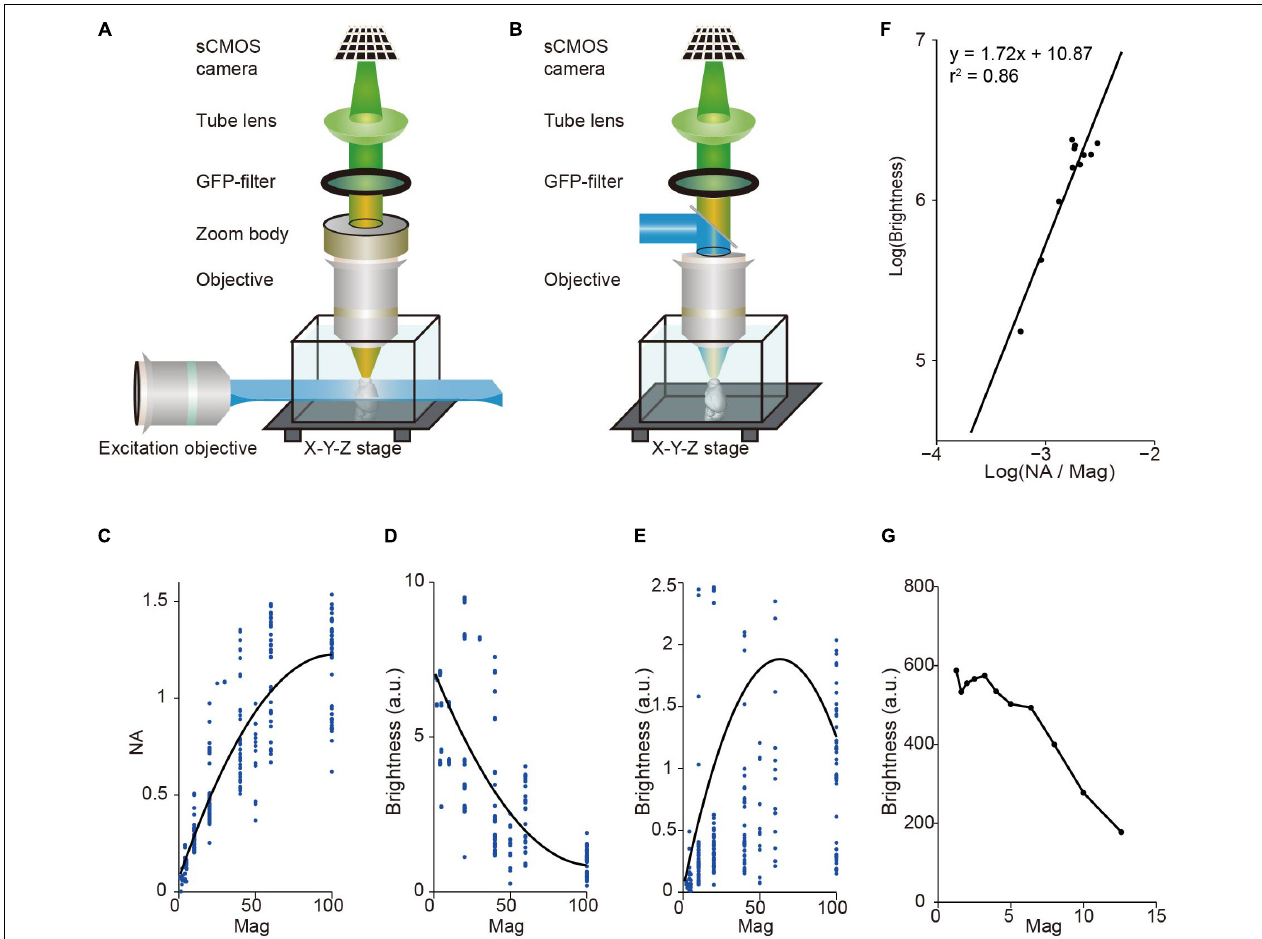
FIGURE 1 | Image brightness in light sheet fluorescence microscopy (LSFM) and wide-field fluorescence microscopy. (A) LSFM is based on the principle of decoupling illumination and detection by generating a thin “sheet” of light from the side using a dedicated objective to induce optical sectioning. (B) Wide-field epi-fluorescence microscopy uses the same objective for specimen illumination and fluorescence detection. This approach couples illumination and detection. (C) Numerical aperture (NA), on average, increases monotonically with magnification for commercial objectives. Dots, individual objectives (Nikon and Olympus, downloaded from official websites). Black curve, fitted with a second-order polynomial function. (D) Brightness, on average, decreases monotonically with magnification for commercial objectives in LSFM. Same data as in (C) . Black curve, fitted with a second-order polynomial function. (E) Relationship between brightness and magnification for epi-fluorescence microscopy (same objectives as in C,D ). Brightness is highest around 60 × magnification, indicating that using oil immersion objectives with 40–60 × magnification can achieve brightest images. Note that dotes above 2.5 are not shown. Black curve, fitted with a second-order polynomial function. (F) Measured signal brightness and NA/Magnification (Mag) (dots) by imaging a dye pool in LSFM. The brightness of signal is roughly proportional to the square of the numerical aperture, and to the inverse square of the magnification of the detection objective (i.e., brightness ∝ NA 2 /Mag 2 ). (G) Measured signal brightness (dots) at different magnifications in LSFM (same data as in F